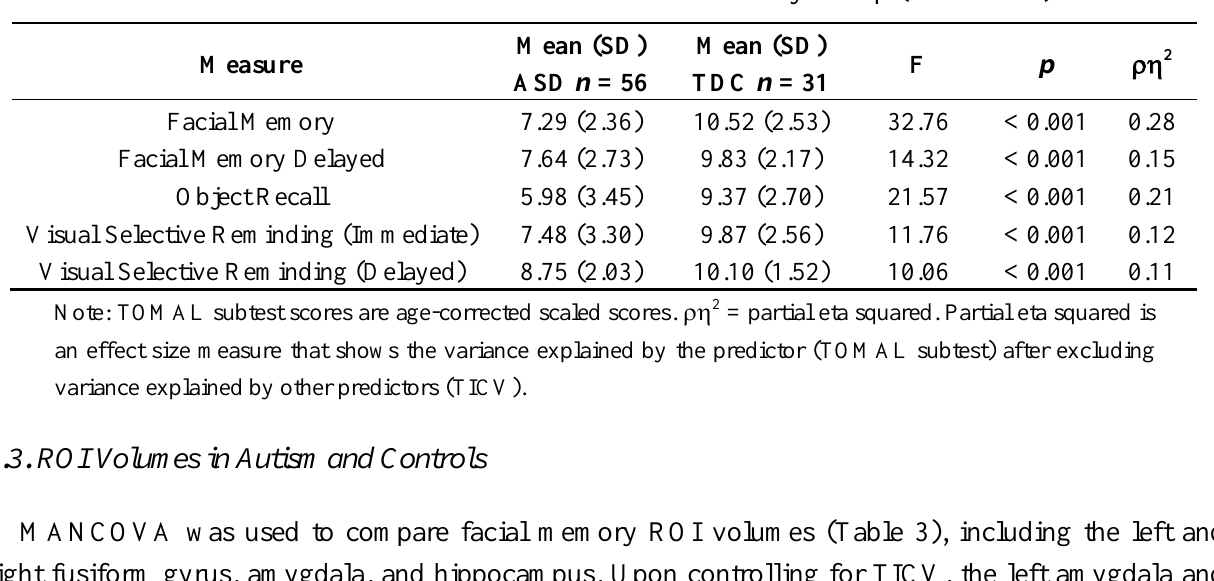
Table 2. Mean Scaled Score TOMAL Performance by Group (MANOVA).